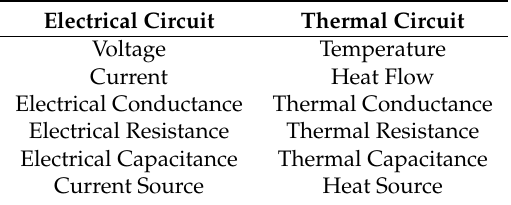
Table 1. Analogy between electrical and thermal